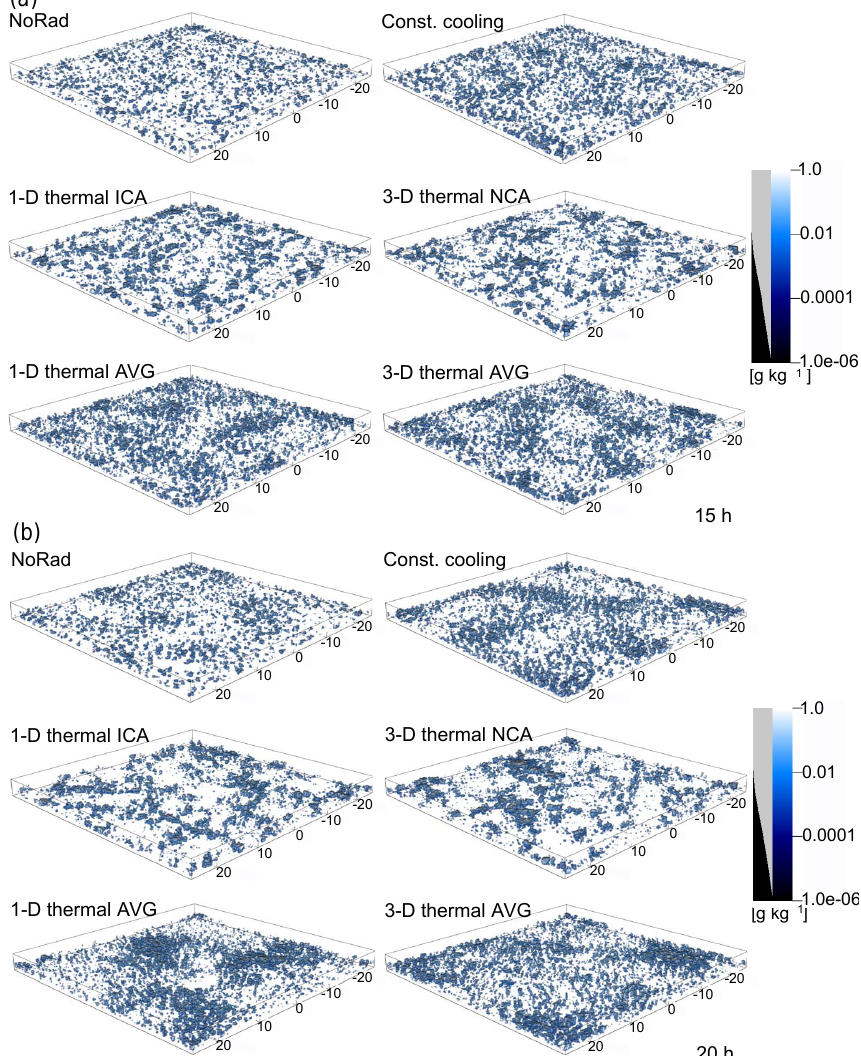
Figure 13. Cloud fields at 15h (a) and 20h (b) of the 50m resolution simulation. The quantity shown is liquid water mixing ratio. The black and gray bar shows the opacity used in this